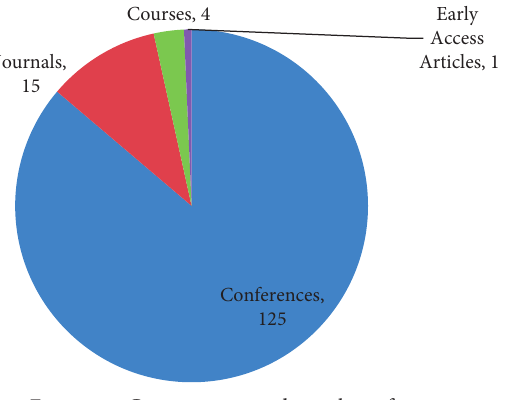
Figure 7: Content type and number of papers.